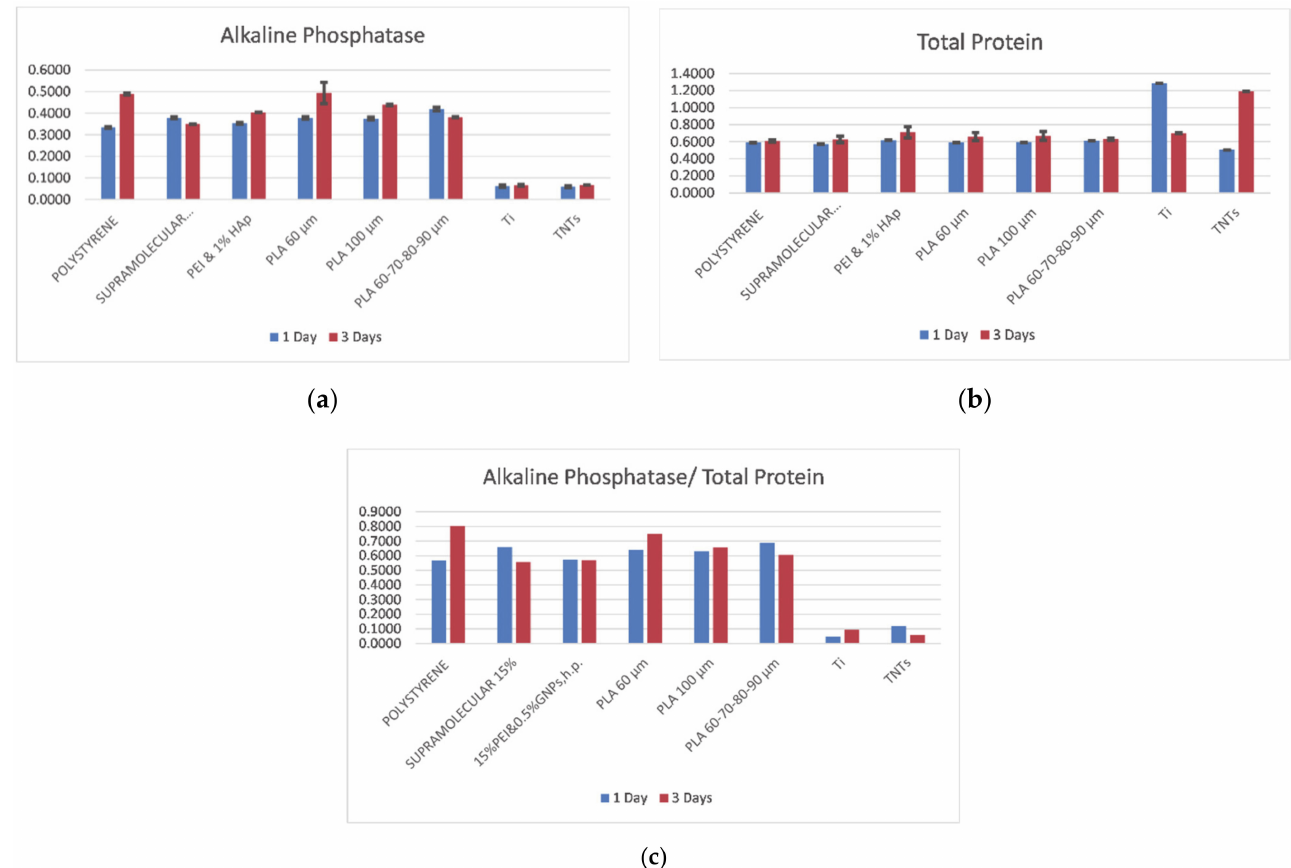
Figure 9. Marker levels expressed in cells seeded on different substrates, after 1 and 3 days of incubation: ( a ) Alkaline Phosphatase ( b ) Total Protein and ( c ) Alkaline Phosphatase/ Total